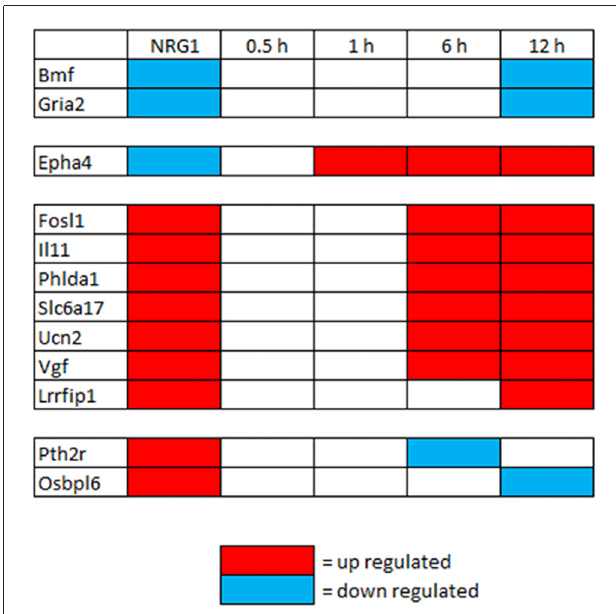
FIGURE 3 | Genes differentially regulated in vitro by NRG1 compared with 0.5–12 h injured nerves. Genes significantly regulated following NRG1 stimulation (101 up- and 89 down-) were compared with genes regulated 0.5 h, 1 h, 6 h, and 12 h after sciatic nerve cut (Yi et al., 2017). Among them, seven up-regulated and two down-regulated show the same regulation behaviour after 12 h.